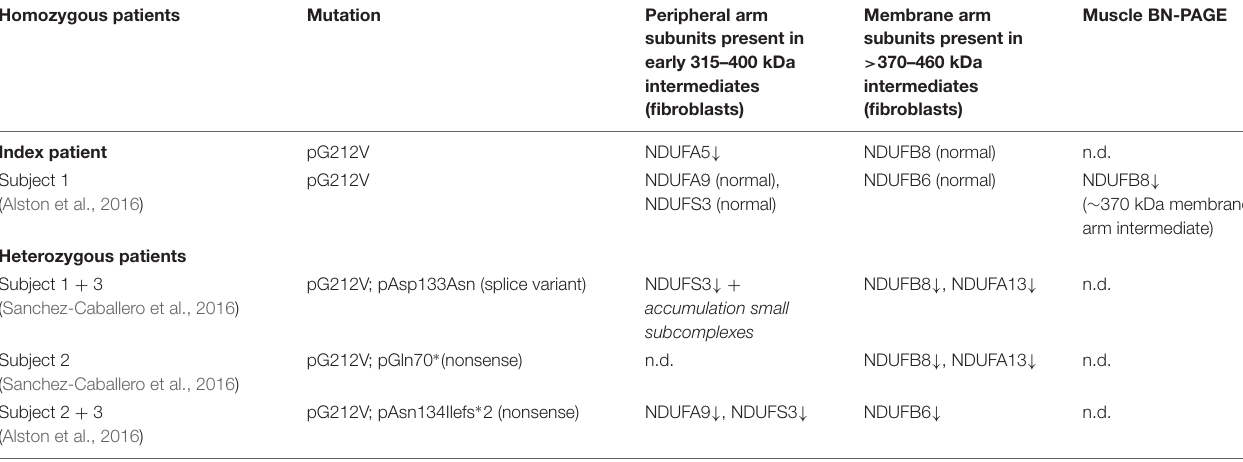
TABLE 3 | The effect of homozygous and compound heterozygous p.G212V TMEM126B mutations on complex I assembly. Homozygous patients